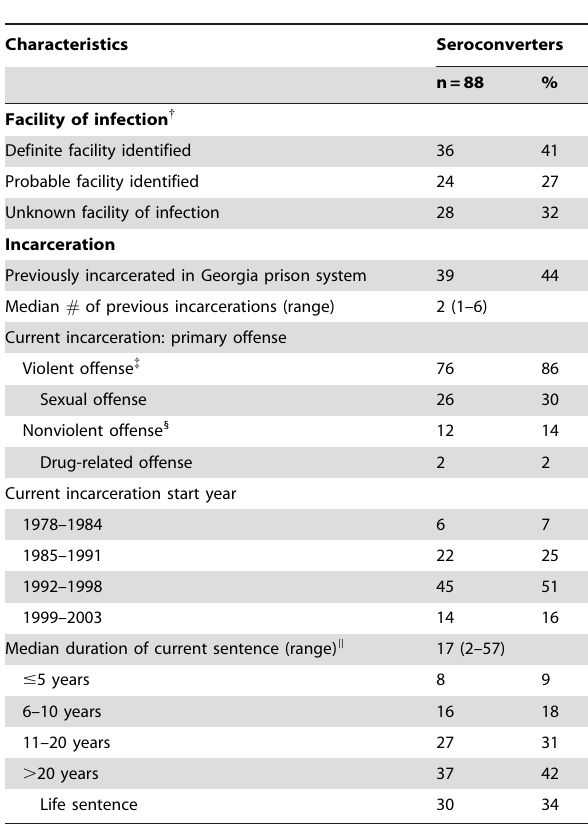
Georgia state prison system a median of two times (range: 1–6 previous incarcerations); 76 (86%) had committed a violent offense, of whom 26 (34%) had committed a sexual offense (Table 1). Forty-five (51%) seroconverters entered prison during 1992–1998, and 30 (34%) were serving life sentences (Table 1). Seroconverters had spent a median of 124 days (range: 4–2437 days) in jail and a median of 7 years (range: 1–20 years) in prison before being diagnosed with HIV. Table 1. Incarceration-related Characteristics of 88 Male Inmates (Seroconverters*) in Whom HIV Infection Was Diagnosed During Their Incarceration, Georgia State Prison System, United States,